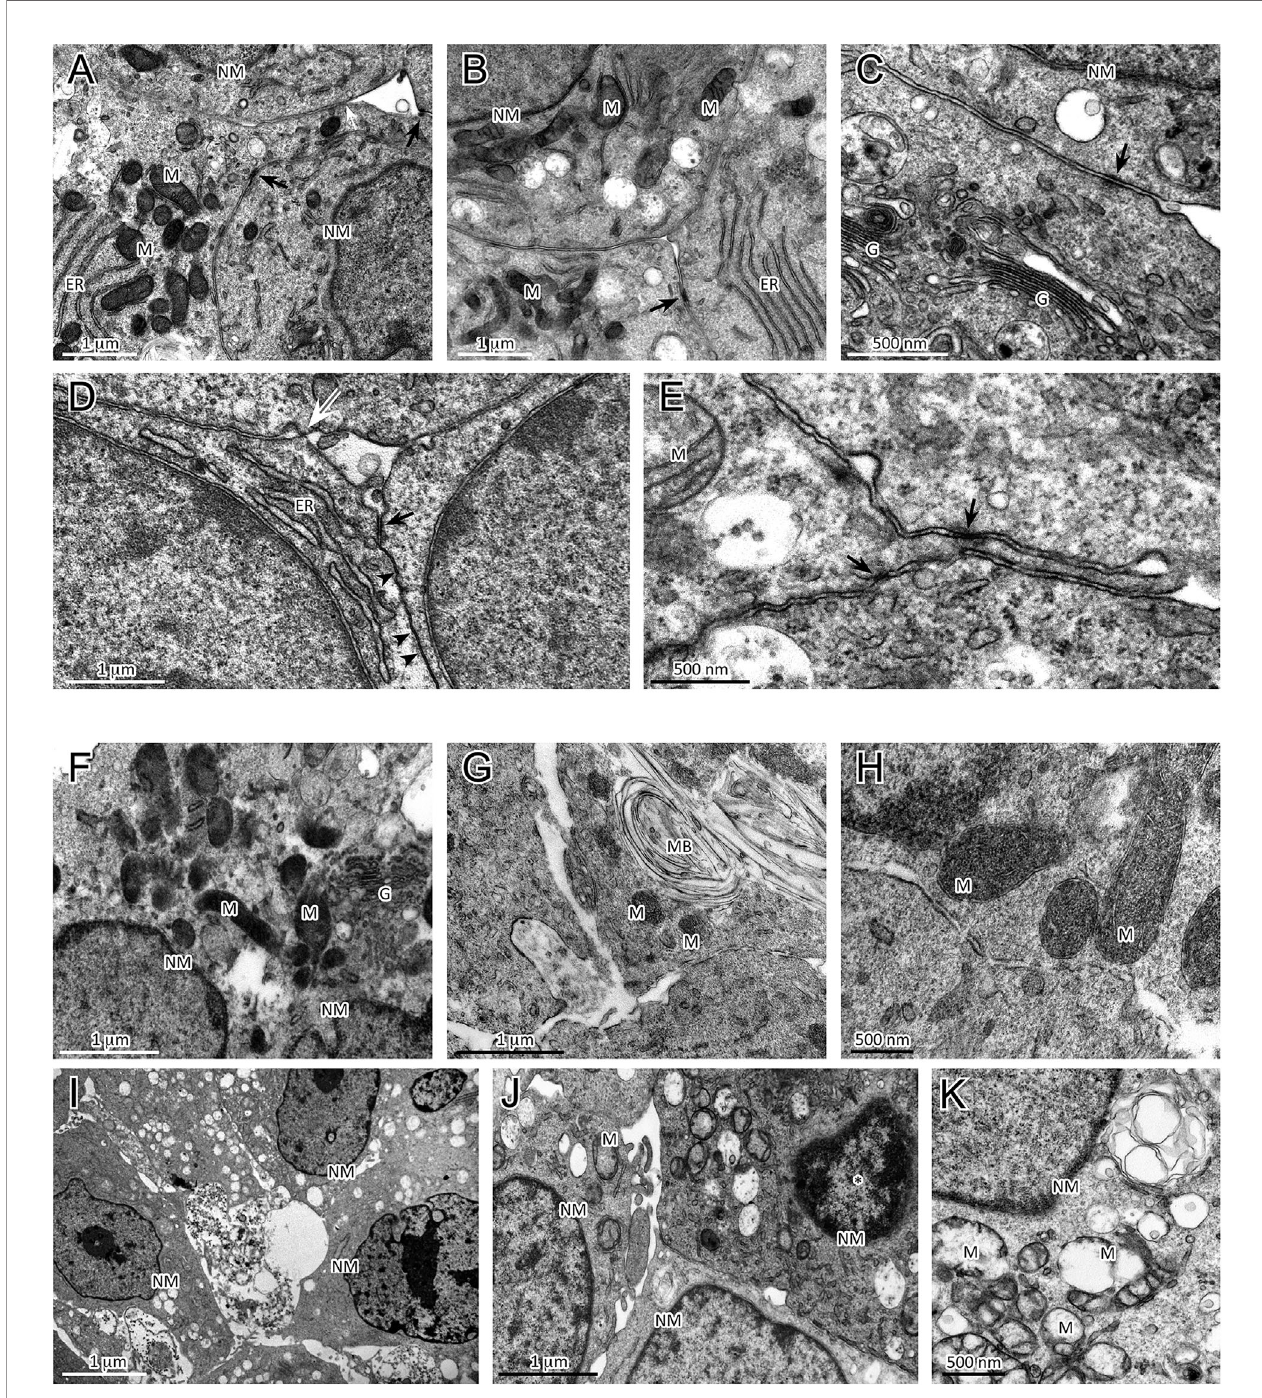
FIGURE 4 | Analysis of ultrastructural features of cellular damage induced by sorafenib 5 µM at 72 h in H295R cultures. The H295R untreated monolayers (A – C) and spheroids (D, E) show nuclei with fi nely dispersed chromatin and prominent nucleoli, and cytoplasms with numerous mitochondria, a variable number of organelles, a prominent Golgi apparatus, many vesicles and a well-developed rough endoplasmic reticulum. Areas similar to tight junctions (white arrow), intermediate junctions (black arrows) and some tight junction-like regions (black arrowheads) are visible. Sorafenib treated H295R monolayers (F – H) and spheroid (I – K) cultures displayed apoptotic nuclei with areas of marginal and dense stained chromatin ( J , asterisk) and nuclear and cellular fragmentation. The mitochondria are swollen and exhibit a loss of internal cristae. Cytoplasmatic vacuolization, swelling of rough endoplasmic reticulum cisternae and myelinic bodies were observed. H295R-treated spheroids show only a few intermediate-like junctions. Legend: NM, Nuclear membrane, M, Mitochondrion; ER, Endoplasmic reticulum; G, Golgi complex; MB, Myelinic body (considered as histological